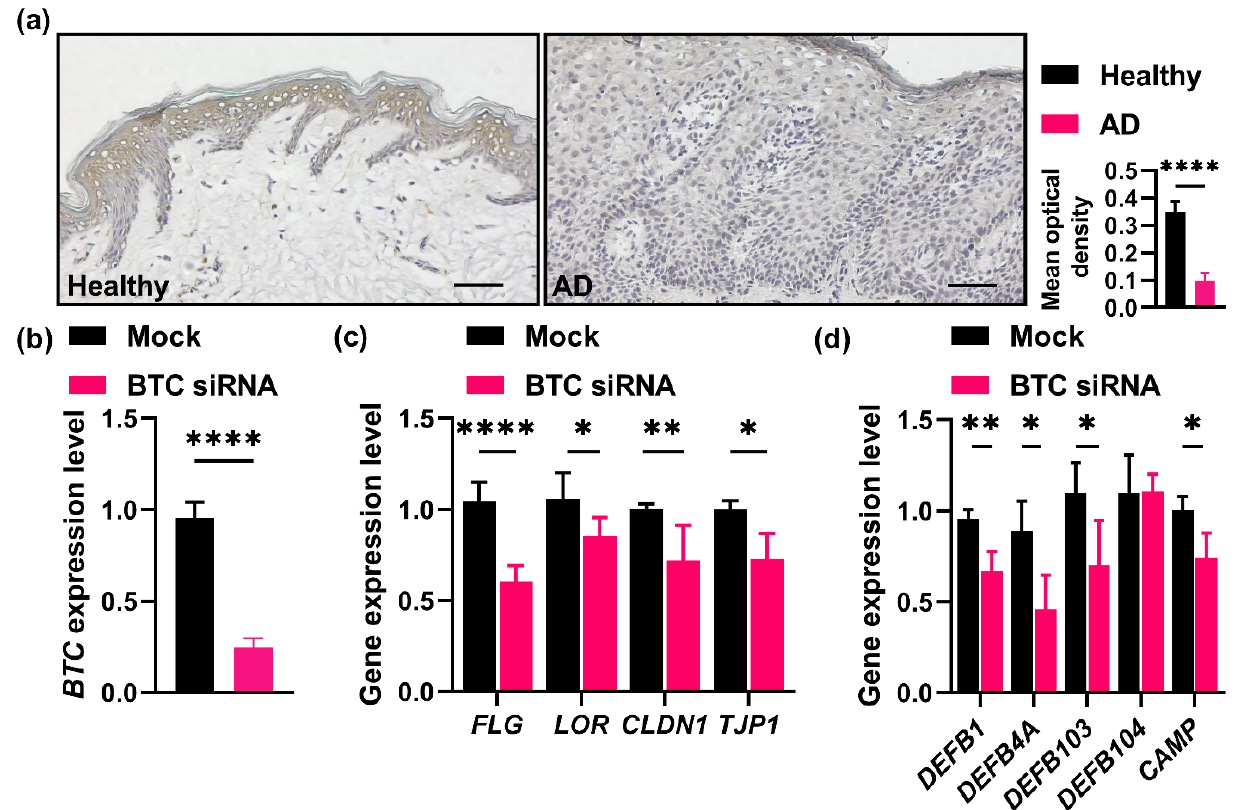
Figure 3. Cutaneous expression and distribution of BTC and effects of its knockdown on human keratinocytes . ( a ). Representative immunohistochemistry images ( left ) and quantification ( right ) of BTC in healthy normal skin tissues and AD lesional skin tissues. Scale bar: 200 μm, n = 5. The mRNA expression levels of BTC ( b ), FLG , LOR , CLDN1 , TJP1 ( c ), DEFB1 , DEFB4A , DEFB103 , DEFB104 , and CAMP ( d ) in keratinocytes in the presence or absence of BTC siRNA were detected. n = 3. * p < 0.05, ** p < 0.01, and **** p <